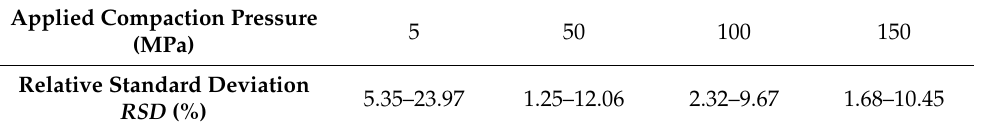
Table 3. RSD values of tablet tensile strength with respect to applied compaction